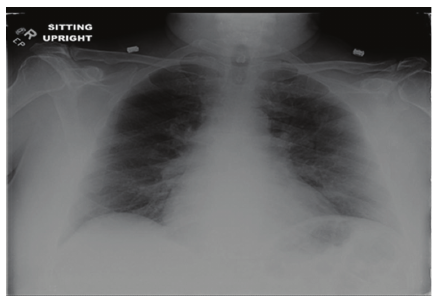
Figure 6: Presurgical chest radiography negative for